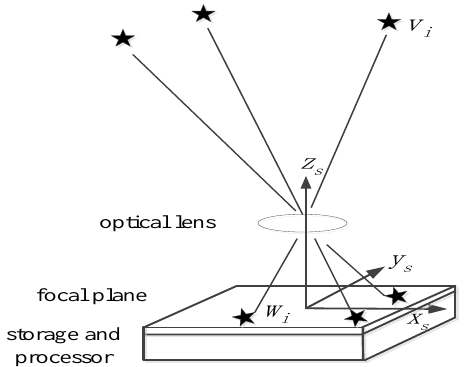
Figure 1. Star tracker ideal imaging